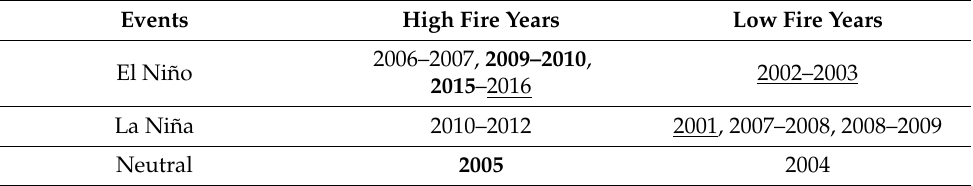
Table 8. Contingency table showing the occurrence of high and low fire years for Jamaica relative to El Niño and La Niña events identified using http://www.bom.gov.au/climate/enso/enlist/ (accessed on 18 August 2020). Values in bold (underlined) are high (low) bushfire years used in the composite